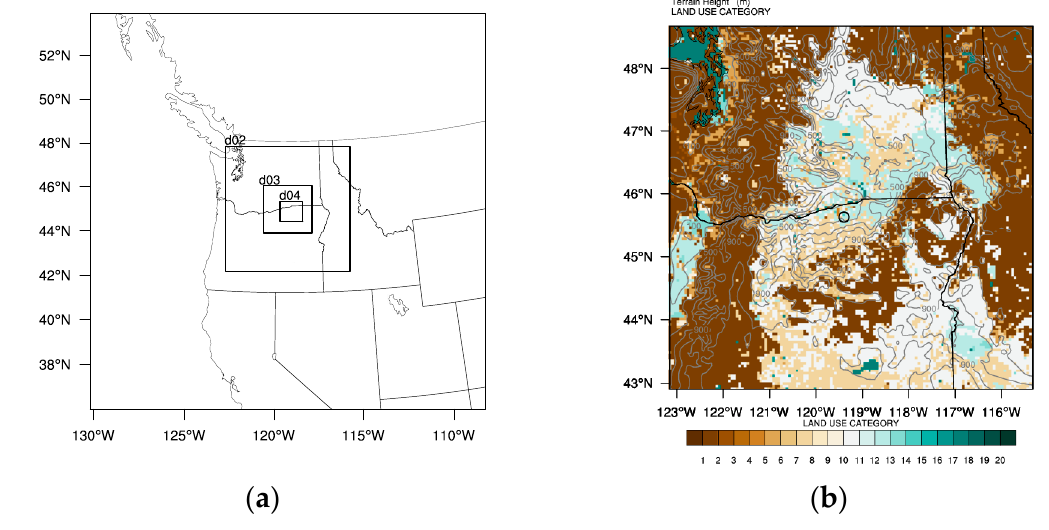
Figure 1. ( a ) WRF two-way nested model domain configuration with horizontal resolutions of 13.5, 4.5, 1.5, and 0.5 km. ( b ) Terrain elevation and land-use categories (MODIS) in the second domain (d02). The MODIS land-use dataset includes 20 categories [33]. The dominant land-use categories in the second domain include forests (brown), shrub lands (light brown), and urban (light blue). The observation site is marked by the hollow circle.